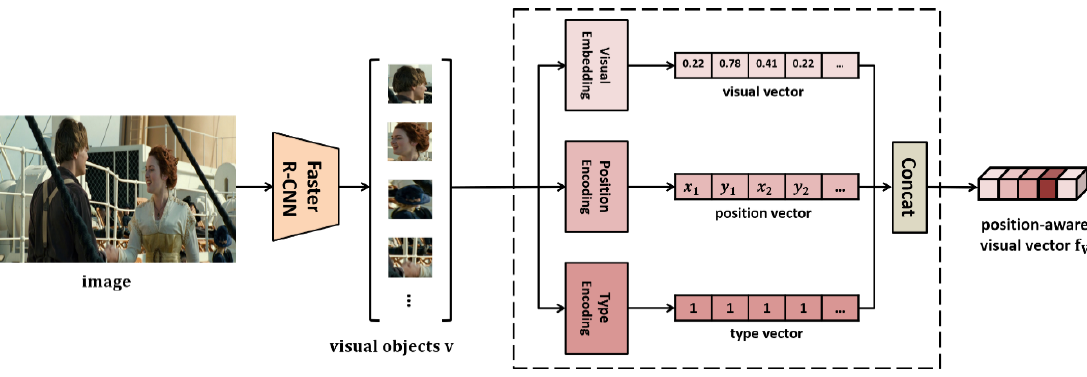
Figure 5. Image embedder.